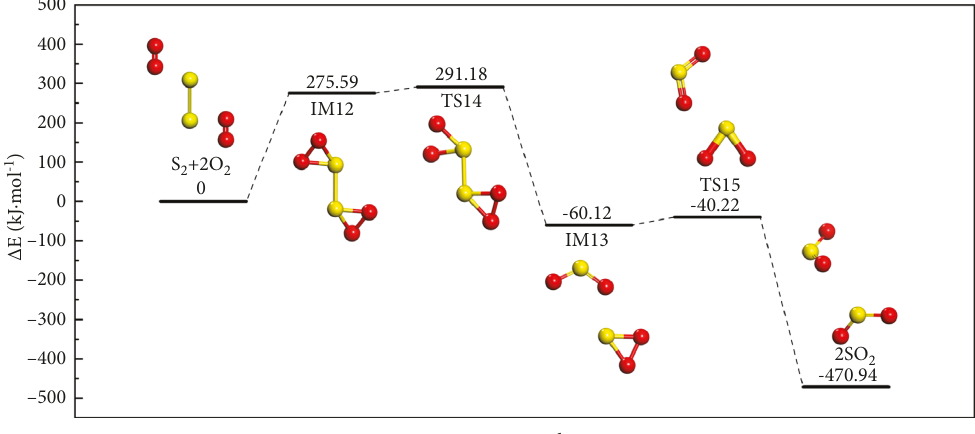
Figure 8: The stage 3 reaction path of S 2 with O 2 on the triplet state potential energy